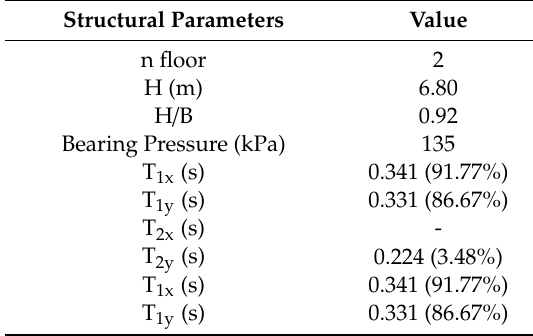
Table 4. Structural characteristics.